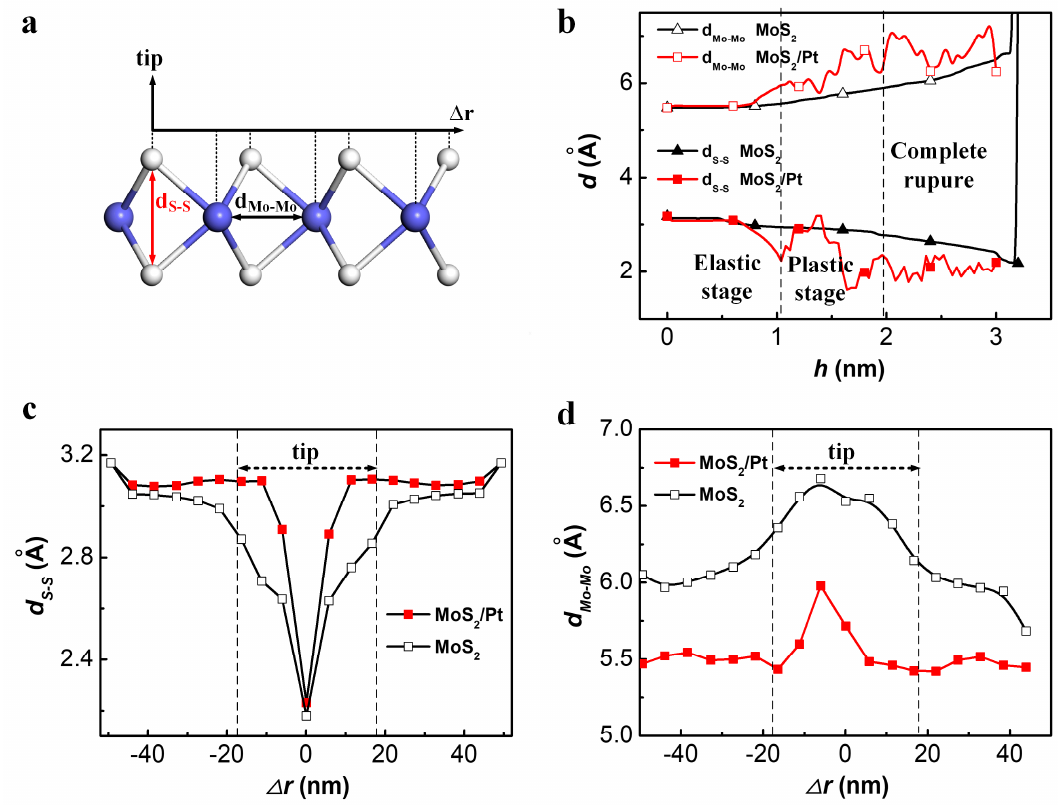
Figure 3. ( a ) Schematic of d S-S and d Mo-Mo ; ( b ) Evolution of d S-S and d Mo-Mo for atoms right under the tip during the indentation process of freestanding MoS 2 monolayer and MoS 2 /Pt substrate; ( c ) The radial distribution of d S-S for MoS 2 monolayer and MoS 2 /Pt substrate at the end of elastic deformation stage; ( d ) The radial distribution of d Mo-Mo for MoS 2 monolayer and MoS 2 /Pt substrate at the end of elastic deformation stage.